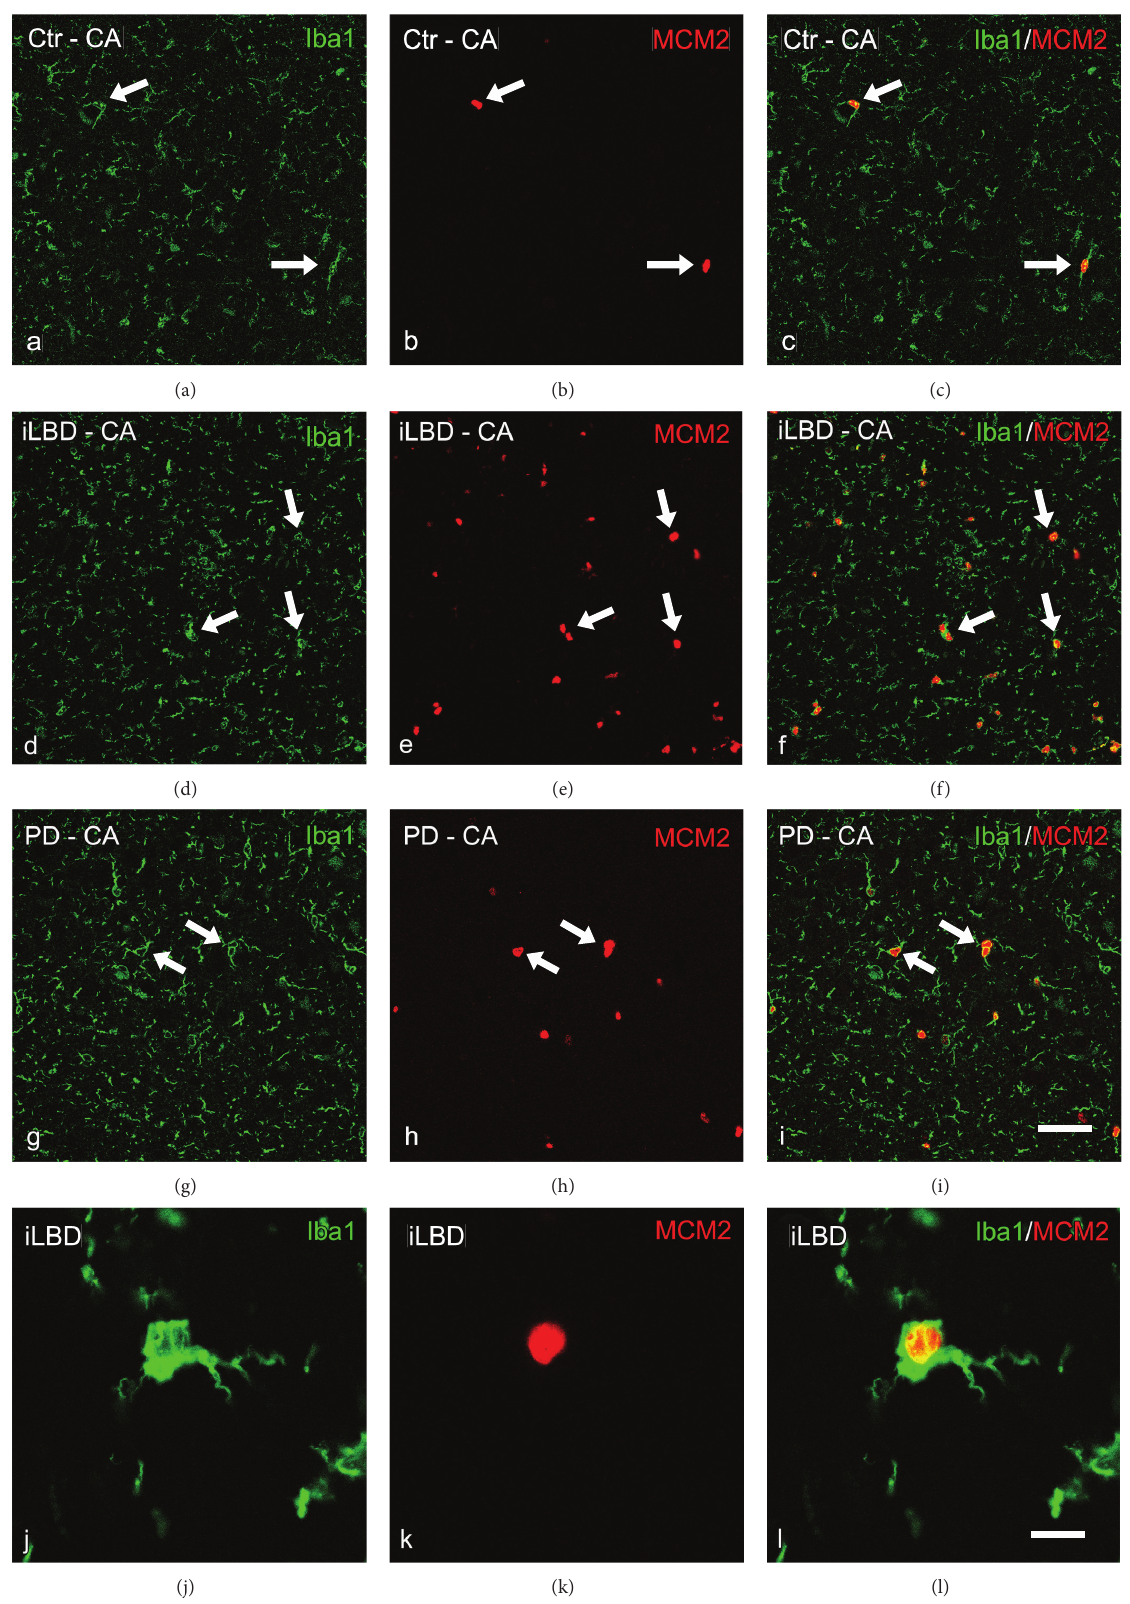
Figure 5: Colocalization of the majority of MCM2-positive cells with Iba1 in the hippocampal CA3 region of control subjects, iLBD cases and PD patients. (a–f) Representative confocal laser scanning microscopical images of double-immunofluorescent stained sections revealed that the majority of the MCM2-positive cells show colocalization with the microglial marker Iba1 (arrows in (c), (f), (i) and (j), and (k) and (l)). Iba1-positive microglia are depicted in green (a, d, and g) and MCM2 in red (b, e, and h). (j–l) Higher magnification of colocalization (l) between Iba1-positive microglia ((j), green) and MCM2 ((k), red); bar (a–i) = 40 𝜇 m; (j–l) = 10 𝜇